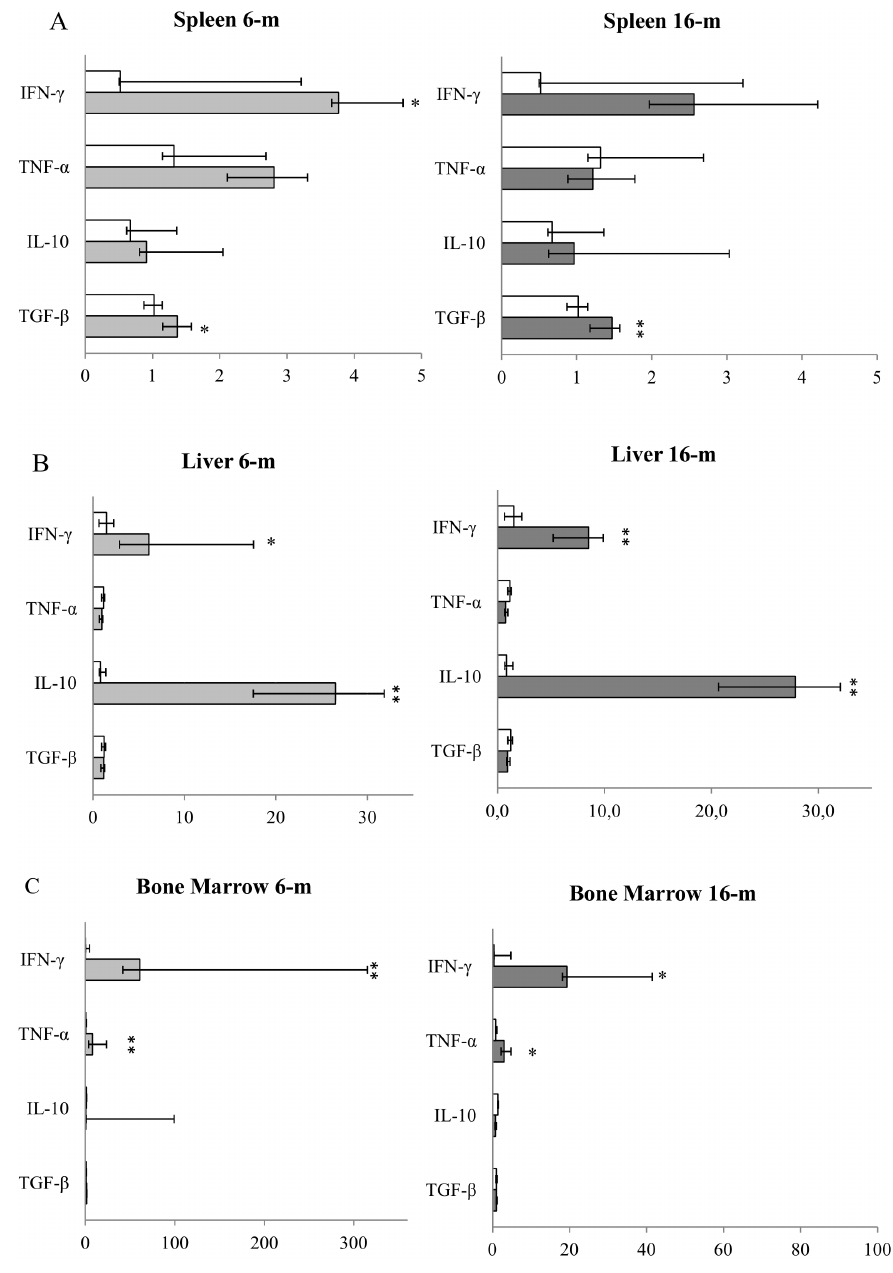
Fig 2. Median cytokine expression in (A) spleen, (B) liver, and (C) bone marrow (BM) samples throughout the course of L . infantum experimental infection. Y-axis: cytokine; X-axis: fold-increase of cytokine expression according to the 2 − ΔΔ Ct method using the mean value of the Δ C of the Non-infected dogs (NID) group as calibrator. White bars: NID; Bright-grey bars: dogs after 6 months (6-m) of L . infantum experimental infection; Dark-grey bars: dogs after 16 months (16-m) of L . infantum experimental infection. Significant differences in median cytokine levels among groups are indicated by * P < 0.05, ** P < 0.01, *** P <